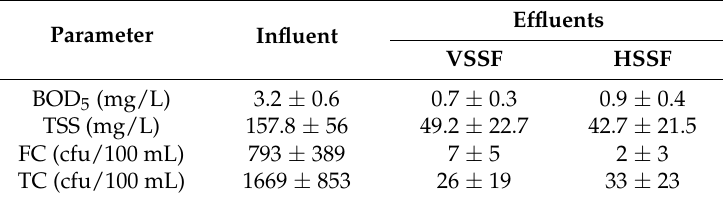
Table 1. Average characteristics of natural stream water at the influent and effluents of VSSF and HSSF wetland units.